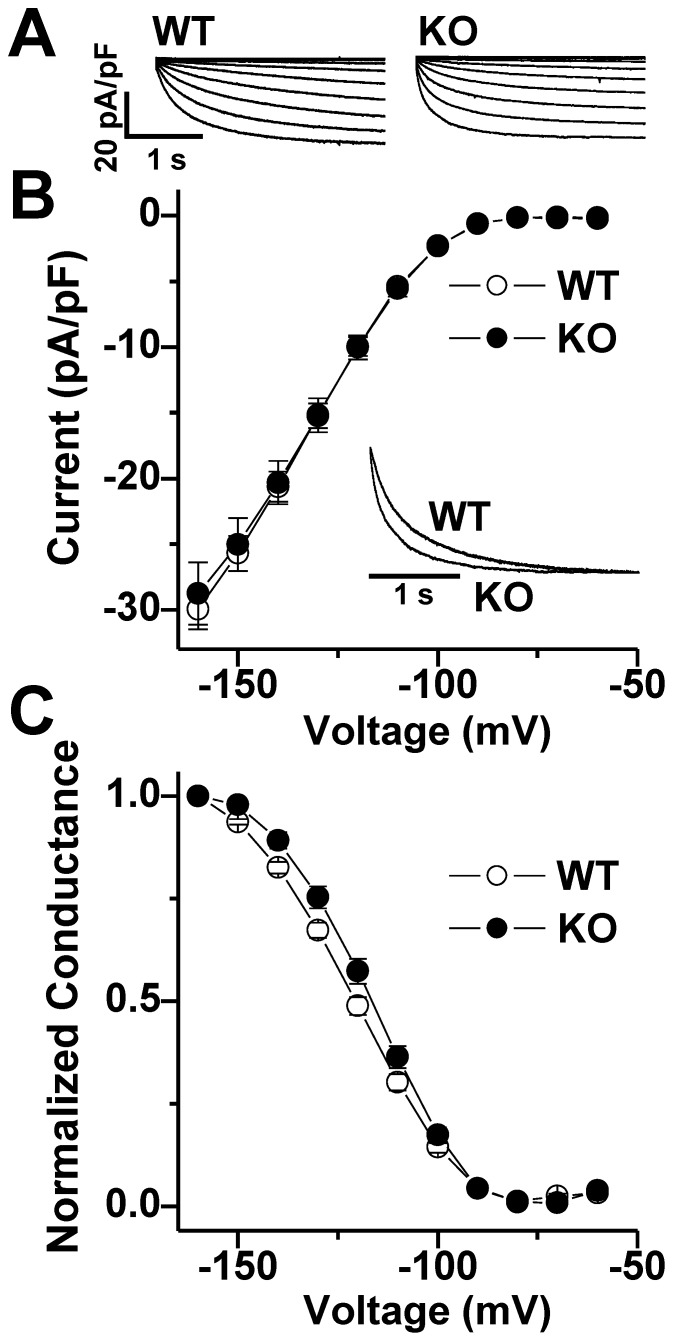
Funny current (If) in WT and atrial-specific NCX1 KO SAN cells.
A. Representative If current families (normalized to capacitance) in response to test clamps ranging from –60 to –160 mV in WT (left) and KO (right) SAN cells. B. There is no difference in the average peak current-voltage relationship for If recorded from 29 WT (open circles) and 40 KO SAN cells (closed circles). Inset: superimposed normalized current traces at –160 mV in a WT and KO SAN cell. C. Average conductance-voltage relationships for If in WT (open) and KO (filled) cells.